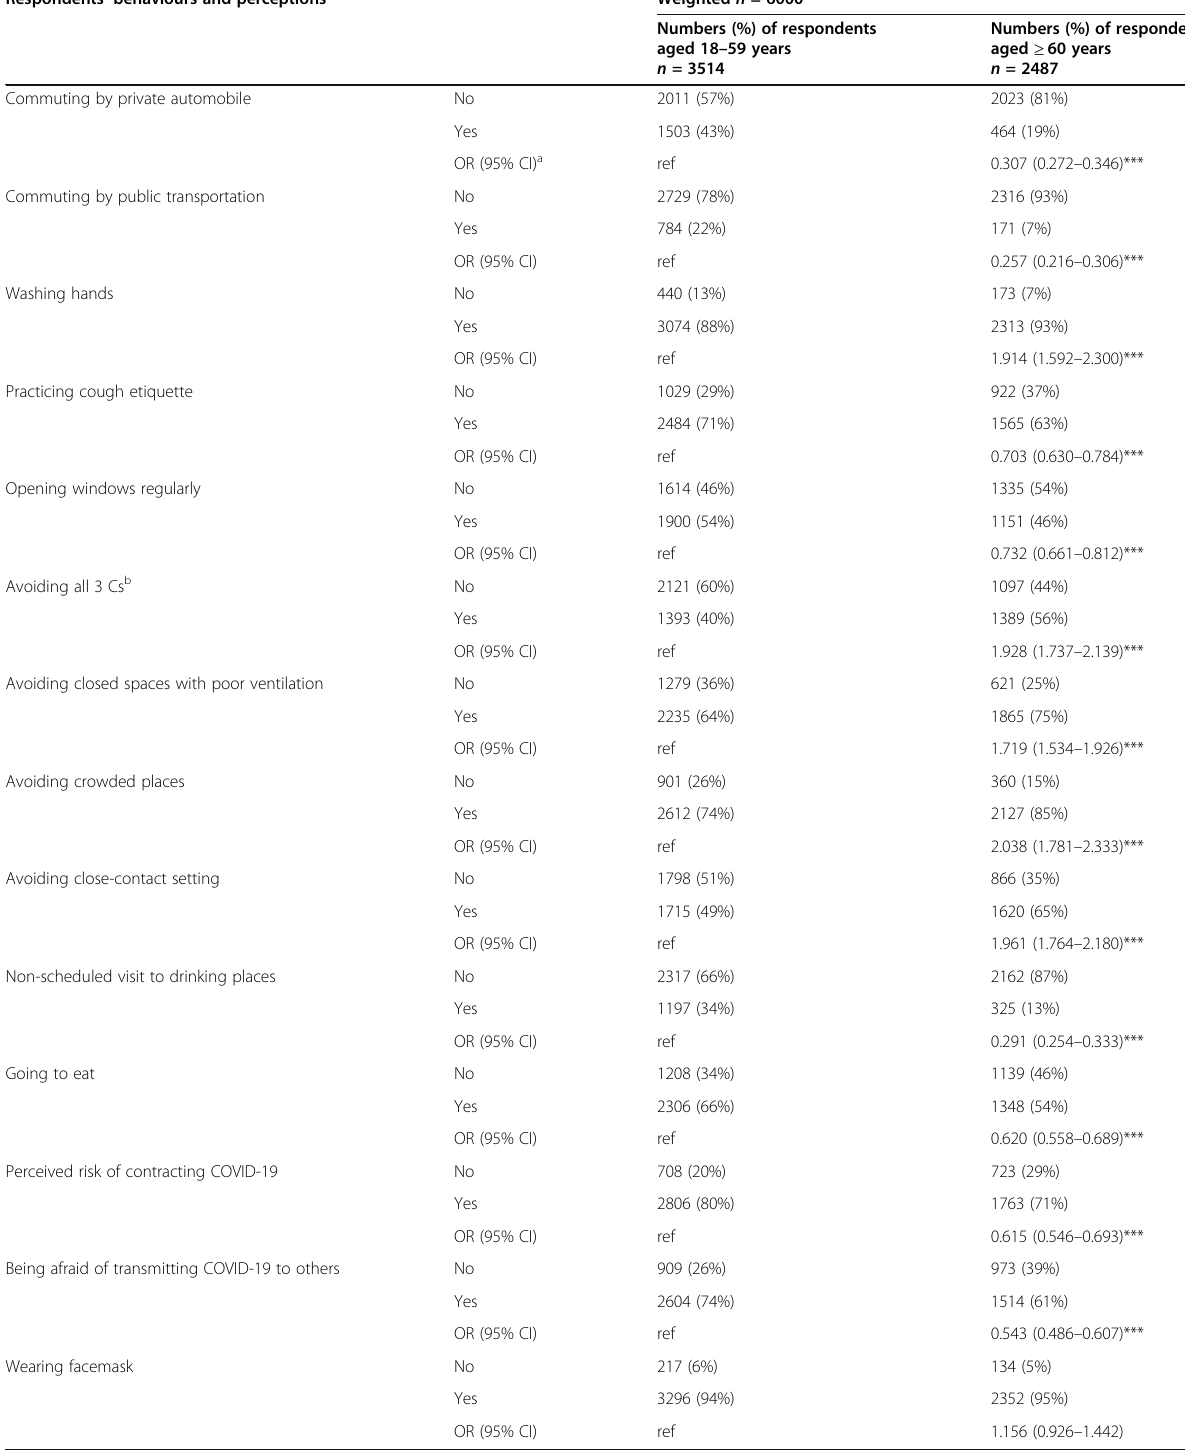
Table 3 Associations between behaviours/perceptions and age